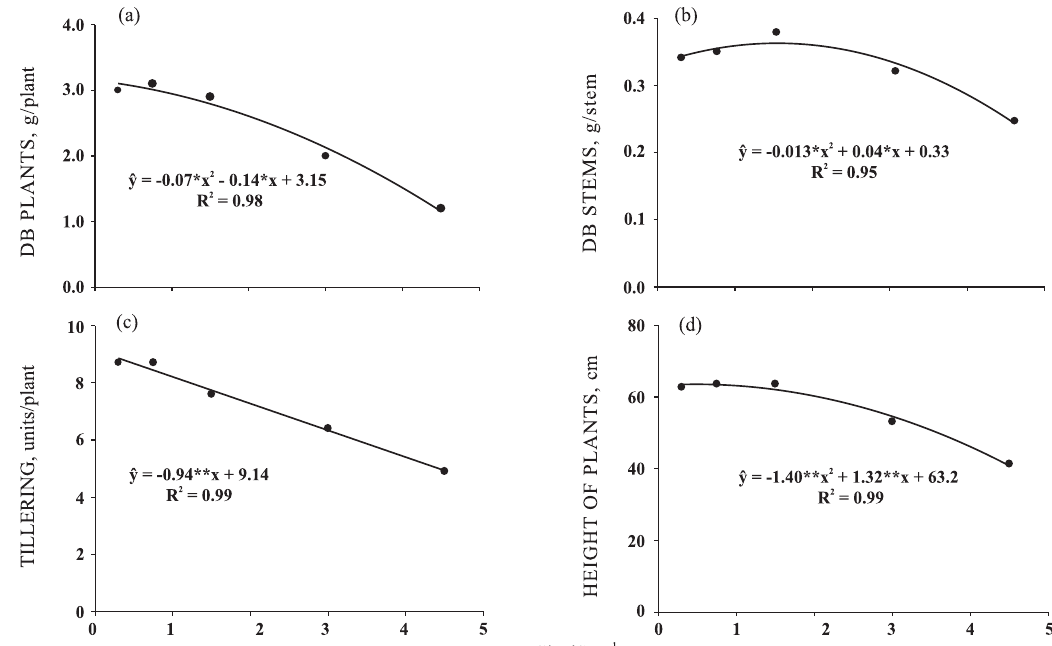
Figure 3. Dry biomass (DB) of plants (a) dry biomass of stems (b), tillering (c) and height (d) of rice plants, according to the electrical conductivity of the water layer (ECi). *, **: significant at 5 and 1 %, respectively, by F